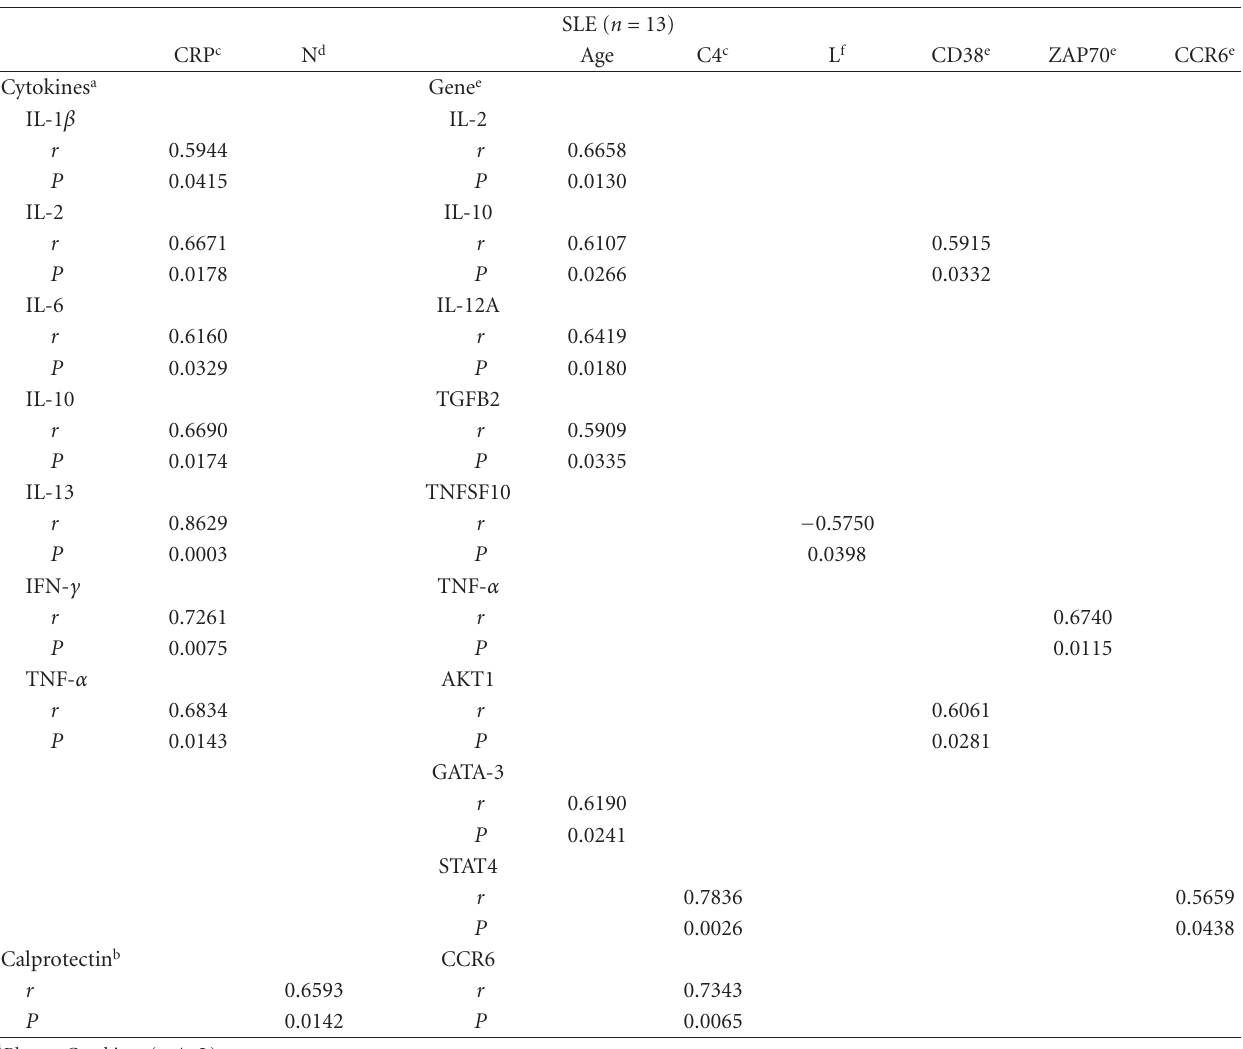
Table 8: Spearman’s rank correlation test.